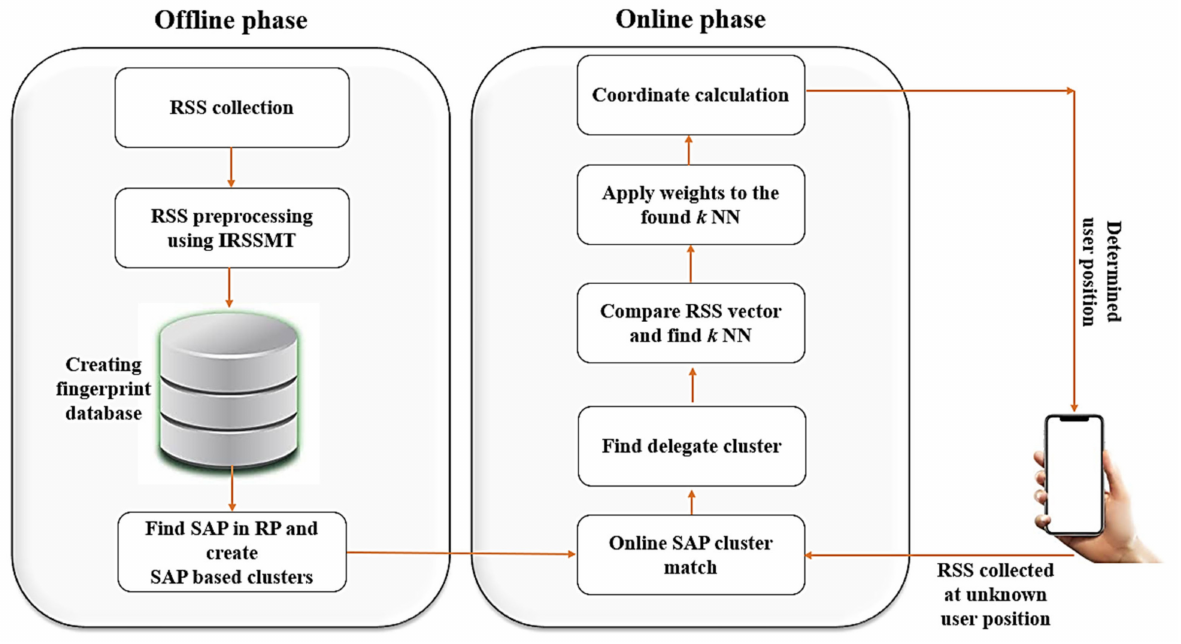
Figure 1. The overall structure of the proposed